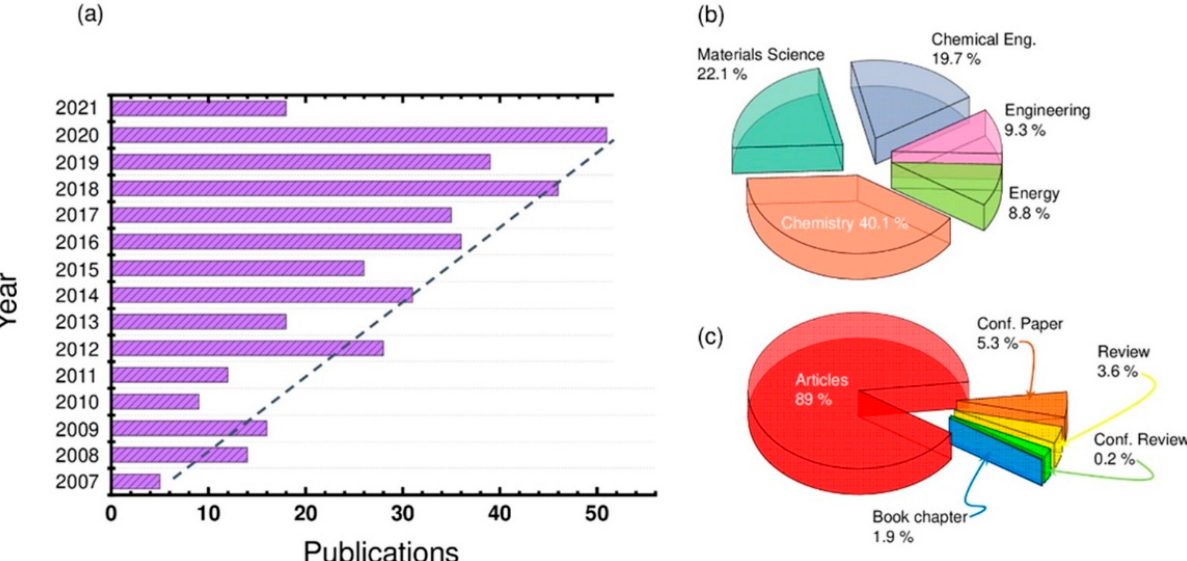
Figure 1. ( a ) Histogram distribution of the studies performed on the redox-active ionic liquids (RAILs) field, from 2007 to date, and ( b ) their respective distribution of the publications per discipline along with ( c ) the type of published documents. All published languages were included. All document types, including journal and conference articles, report paper, conference proceeding, and monograph published chapters were recorded. Statistics are available from 2007 to April 2021, inclusively. Data were collected from Scopus Expertly curated abstract and citation database based information service.